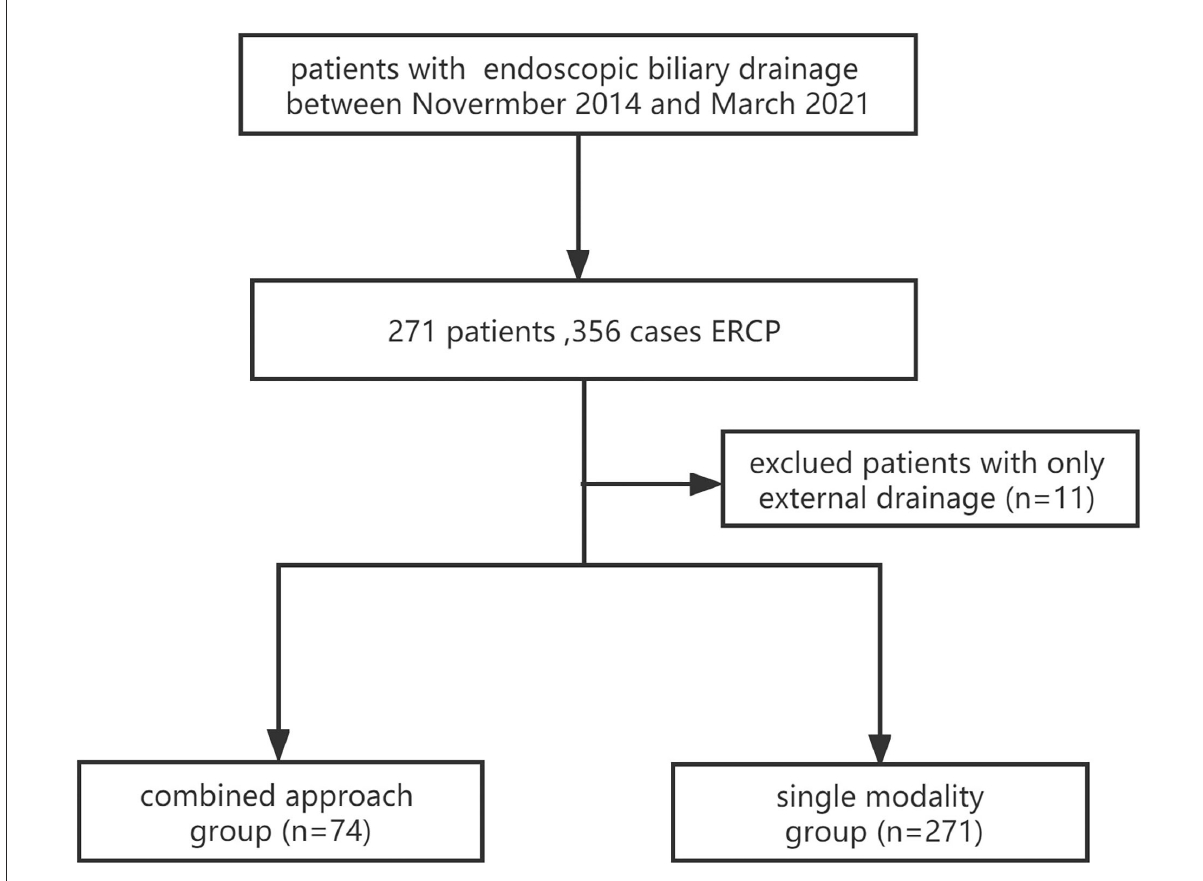
FIGURE1 A flowchart of the study (the combined approach group: ENBD plus stent; and the single modality group: stent only).